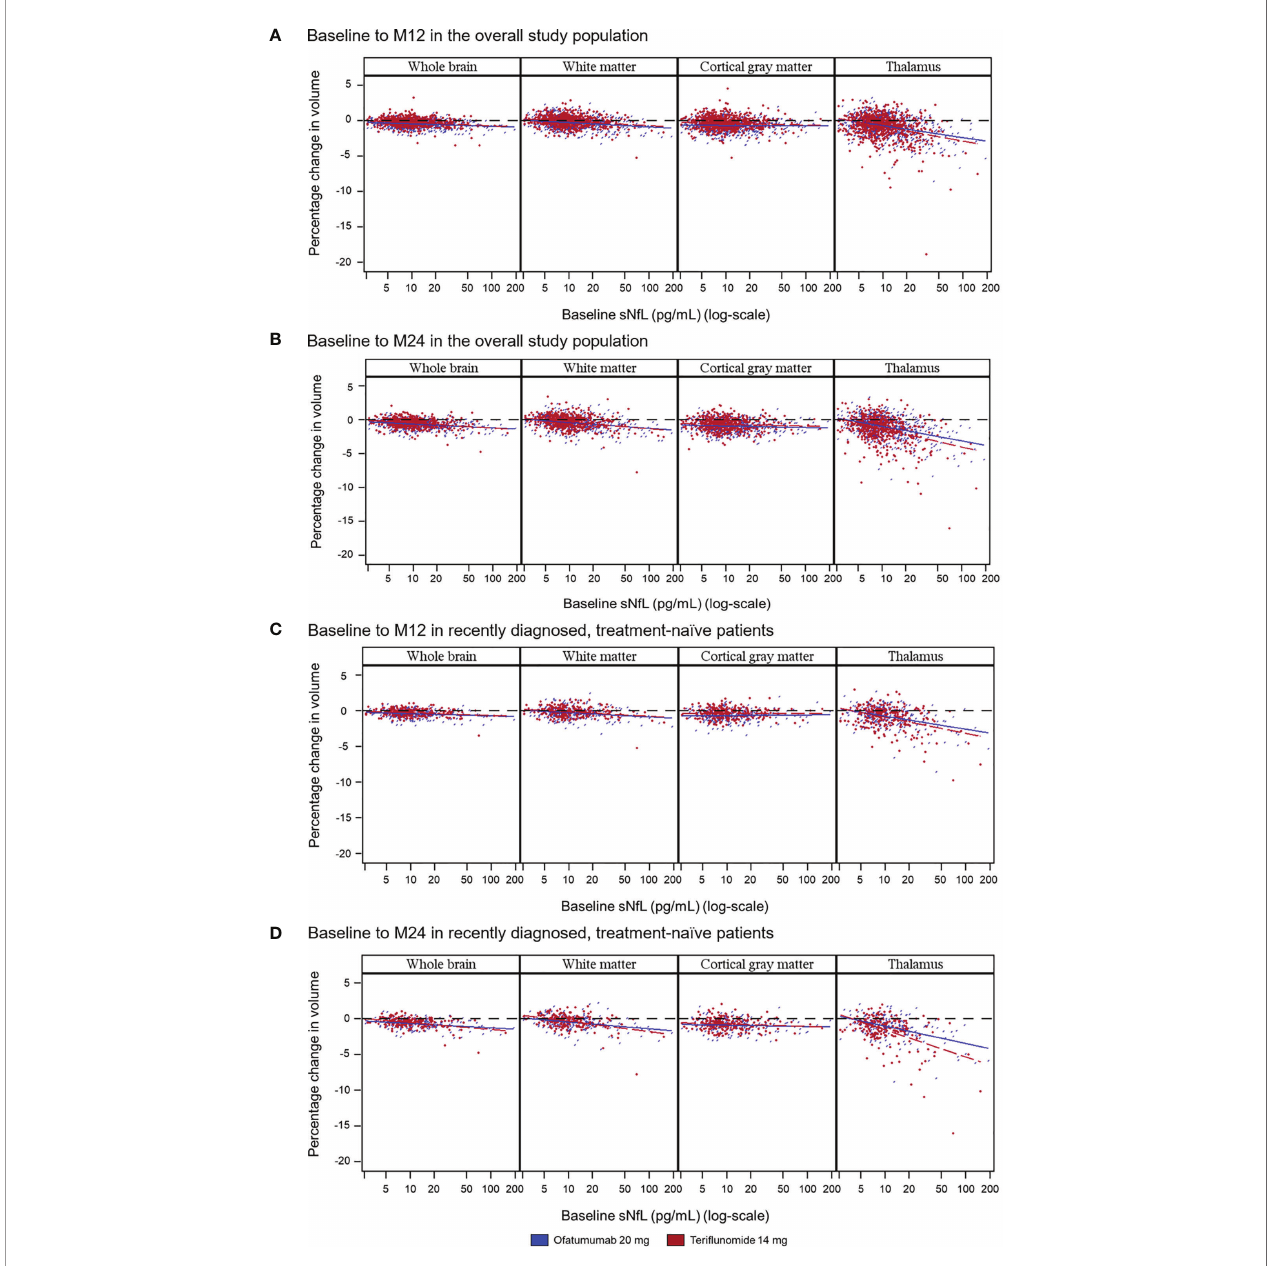
FIGURE 3 | Correlation between baseline sNfL concentrations and on-study whole and regional brain volume change as illustrated in scatter plots over the speci fi ed time period in either the overall population ( A : baseline to M12; B : baseline to M24), or in the subgroup of recently diagnosed, treatment-naive patients ( C : baseline to M12; D : baseline to M24). Random coef fi cients model adjusted for study, treatment, region, and baseline sNfL category as fi xed effects factors; time, baseline number of Gd+ T1 lesions, baseline T2 volume, and normalized brain volume (whole or regional) at baseline as continuous covariates; and treatment-by-time-by- baseline sNfL category interaction and the three corresponding two-way interactions. Gd+, gadolinium-enhancing; M, month; NfL, neuro fi lament light